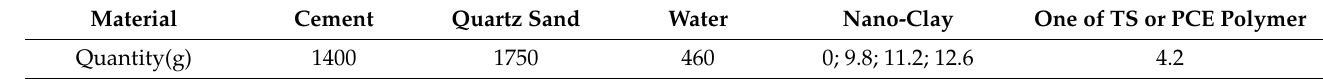
Table 3. Proportion of 3D printed mortars.